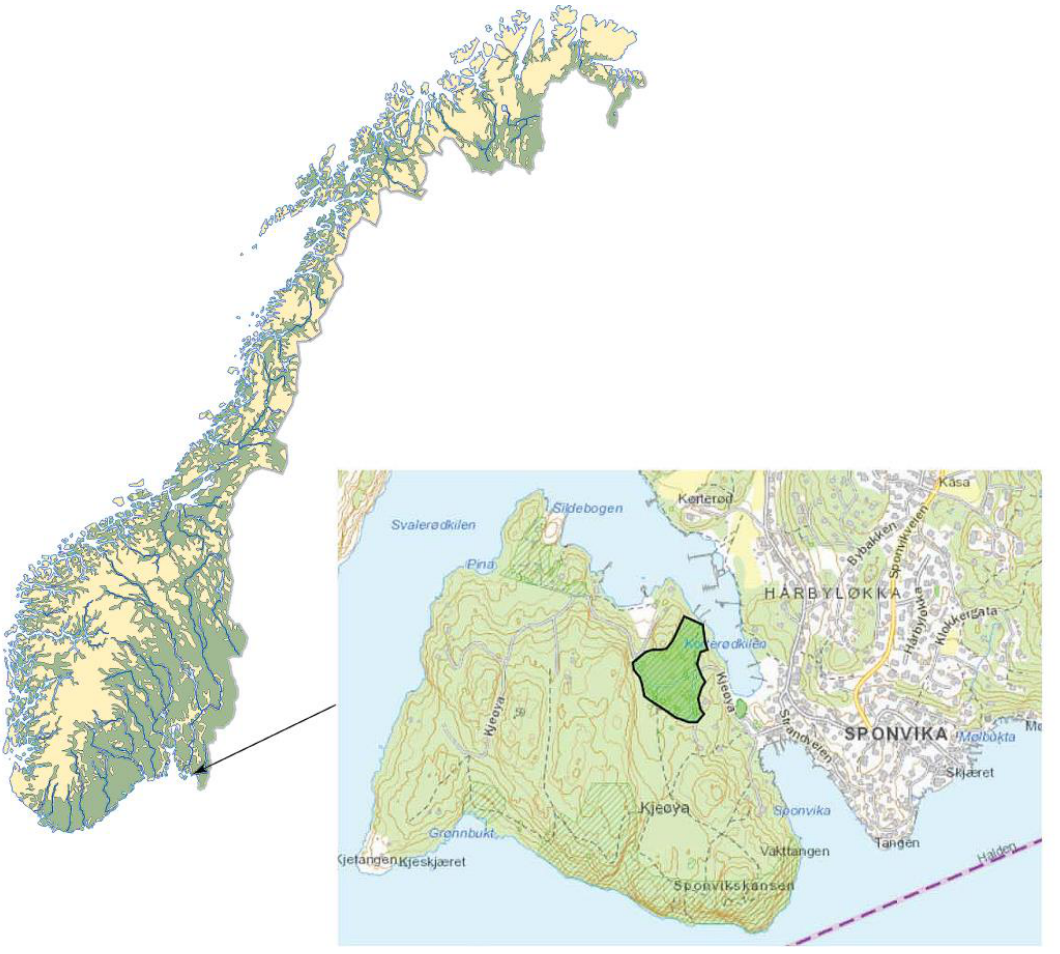
Figure 1. Location in Eastern Norway of the broadleaf forest studied (modified from https://www.norgeskart.no and https://faktaark.naturbase.no, accessed on 8 June 2021).